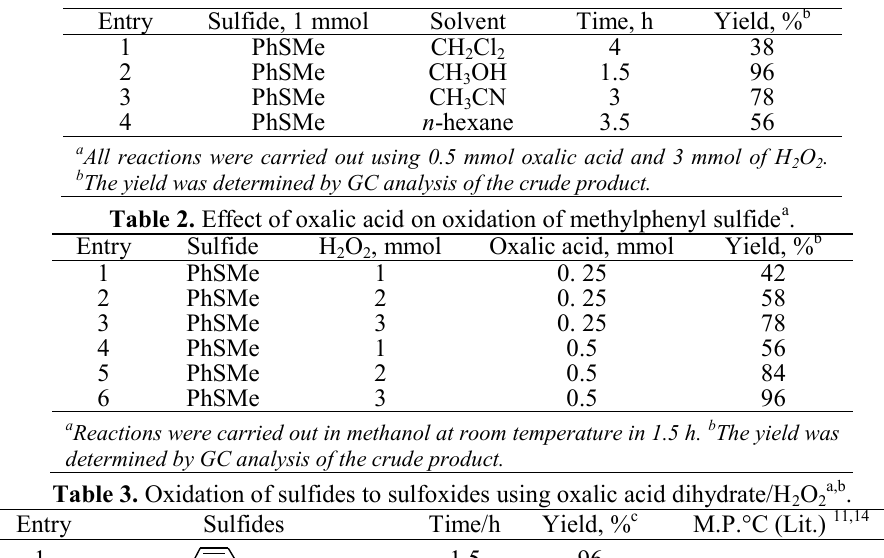
Table 3. Oxidation of sulfides to sulfoxides using oxalic acid dihydrate/H